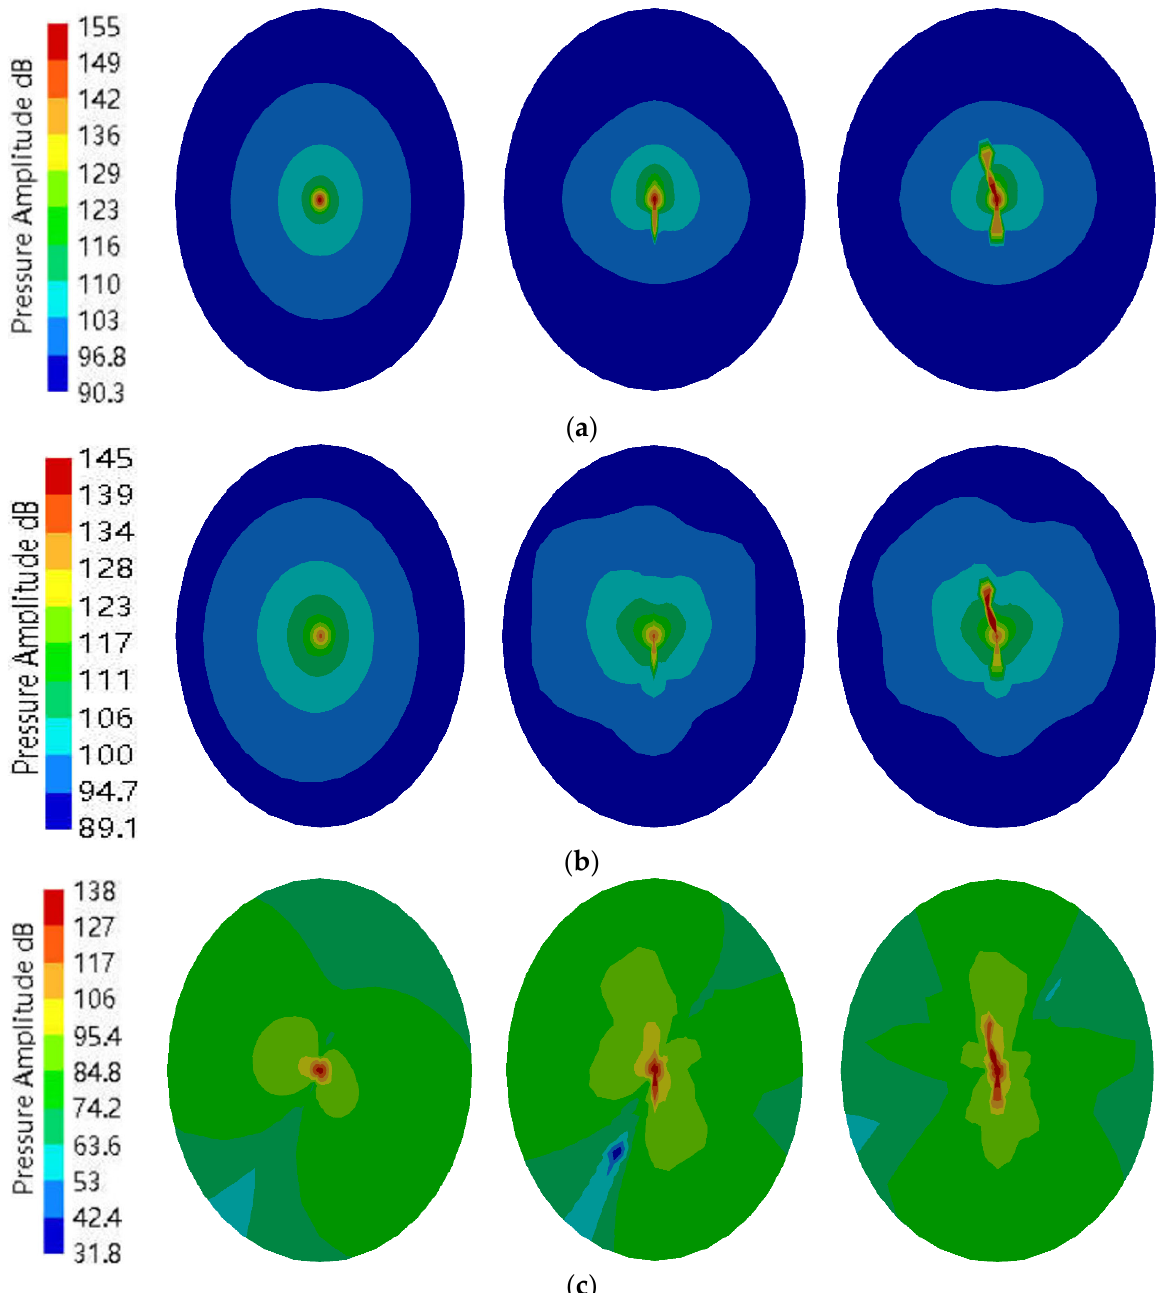
Figure 12. Amplitude distribution of sound pressure amplitude in pump conditions. ( a ) 1.0 Q first ‐ order leaf frequency sound pressure amplitude. ( b ) 1.0 Q second ‐ order leaf frequency sound pressure amplitude. ( c ) 1.0 Q third ‐ order leaf frequency sound pressure amplitude.